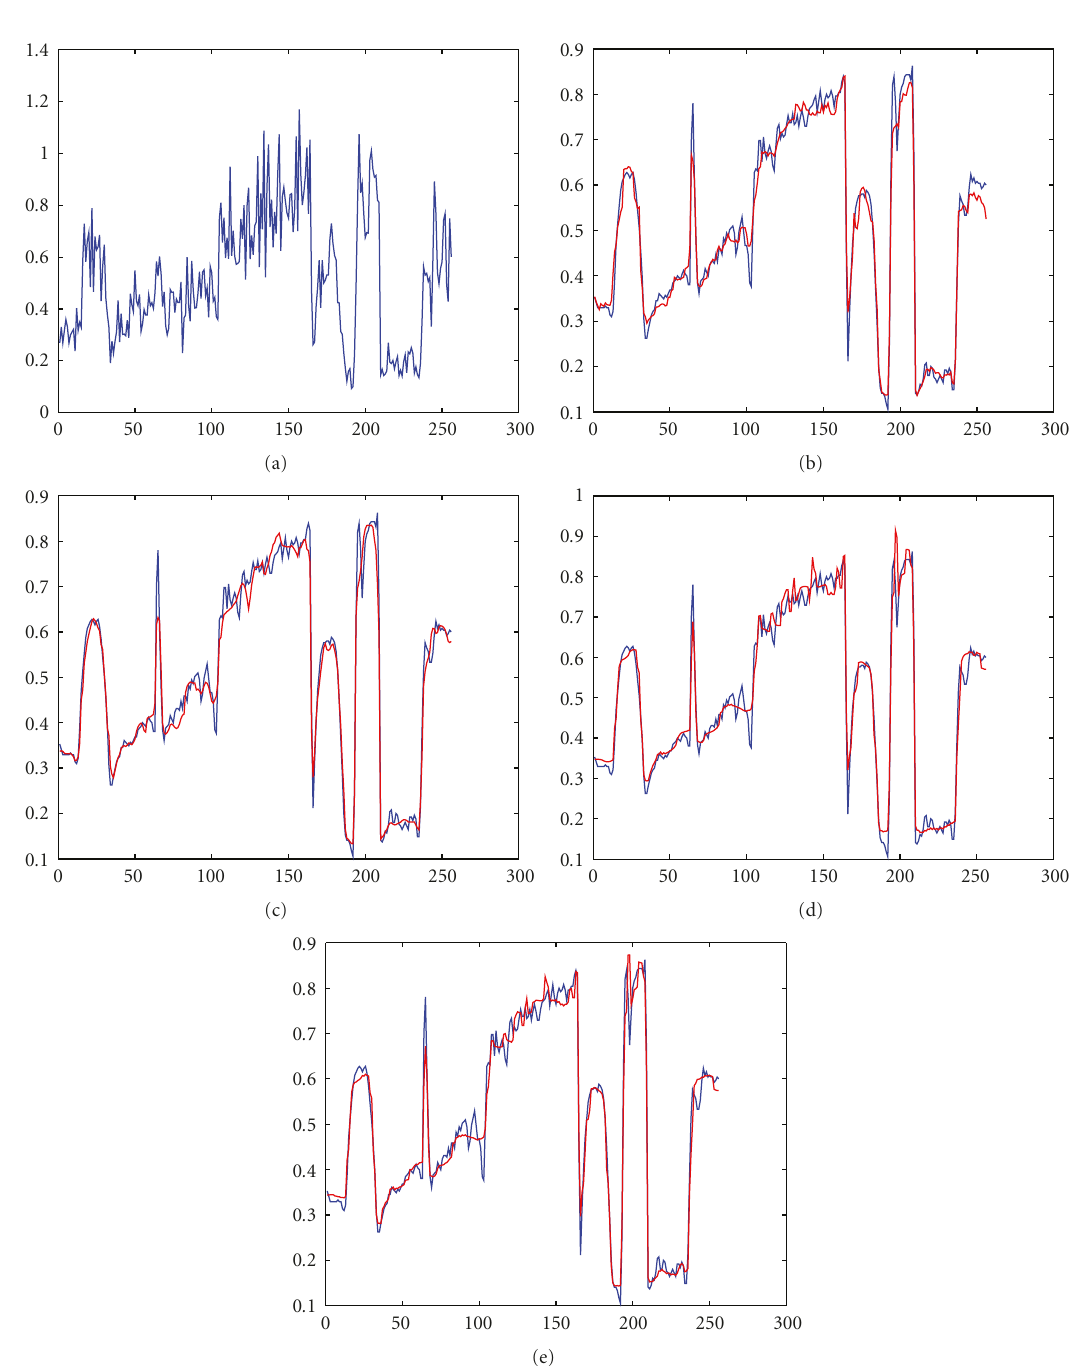
The solution of the “HMW” model